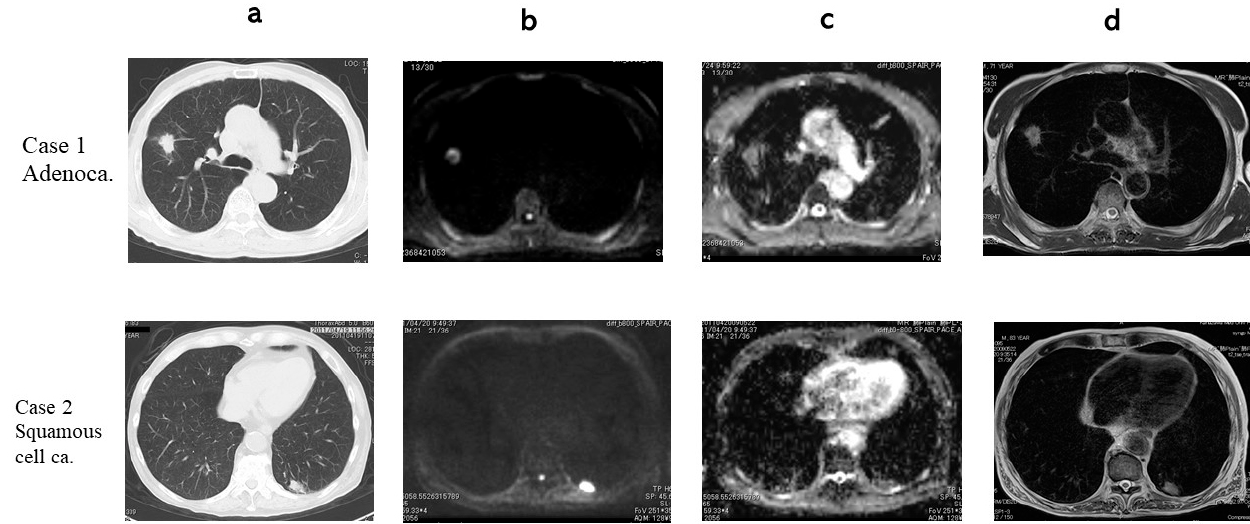
Figure 3. ( a ) CT, ( b ) DWI, ( c ) ADC map, ( d ) T2 WI. Case 1: Adenocarcinoma. ADC 1.39 × 10 − 3 mm 2 /s, T2 CR: 1.67. Case2: Squamous cell carcinoma. ADC 1.04 × 10 − 3 mm 2 /s, T2 CR: 1.25.